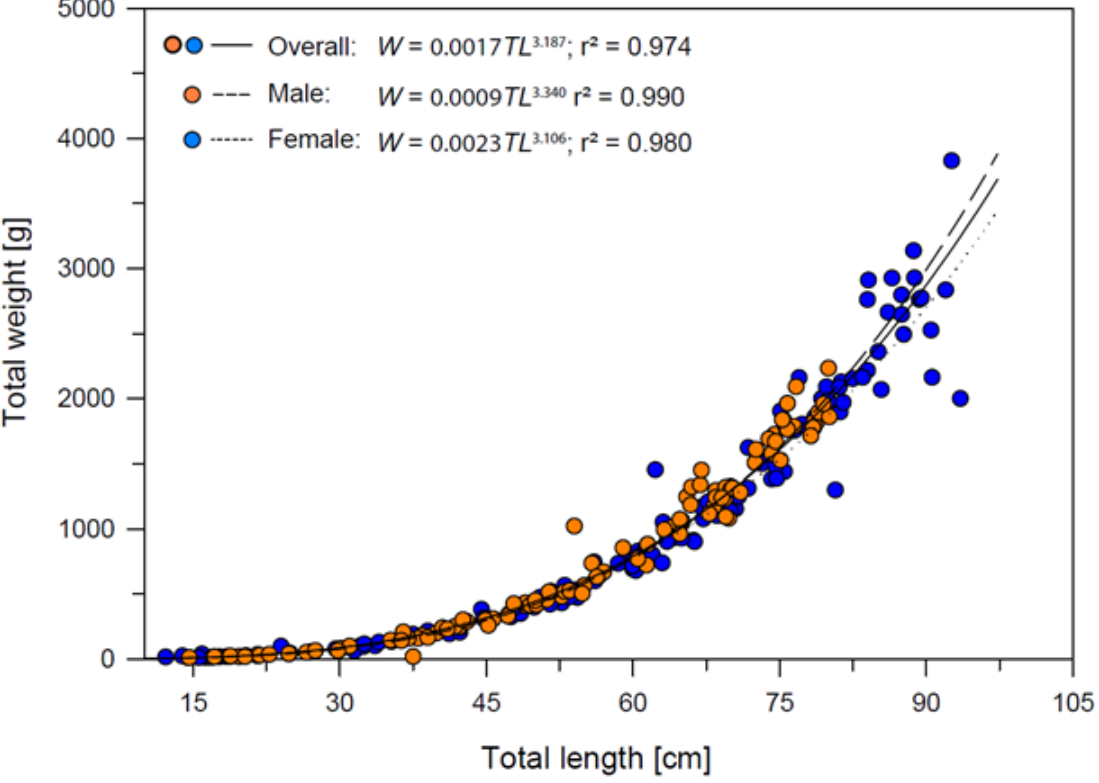
Figure 5. Total length − weight relationships of Dipturus oxyrinchus inhabiting the Northeastern Mediterranean Sea.